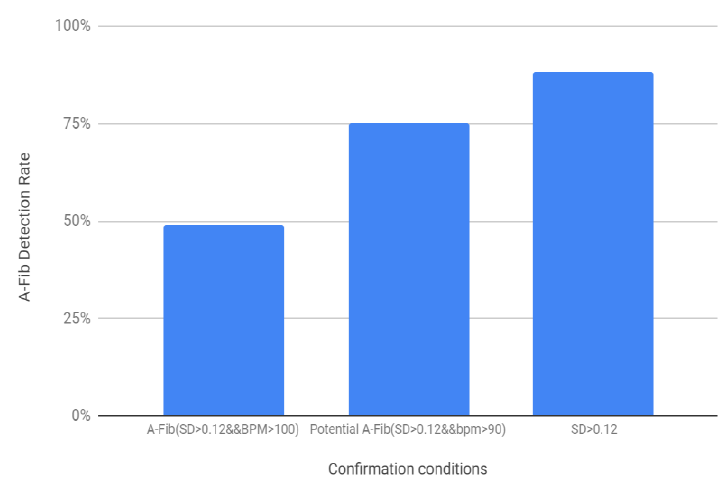
Figure 16. Detection rates for various threshold conditions.